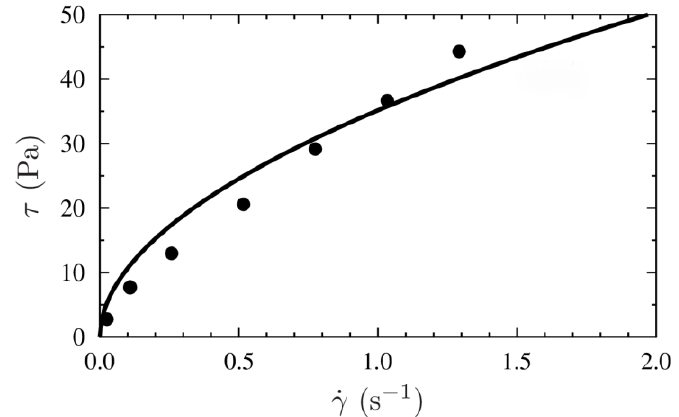
Figure 1. Comparison of the rheogram of the model CMC solution used in the experiments (solid line) with the rheogram of the fresh state UHPC mixture with a negligible value of the yield stress (points). The sedimentation of monodisperse glass spherical particles with a diameter of